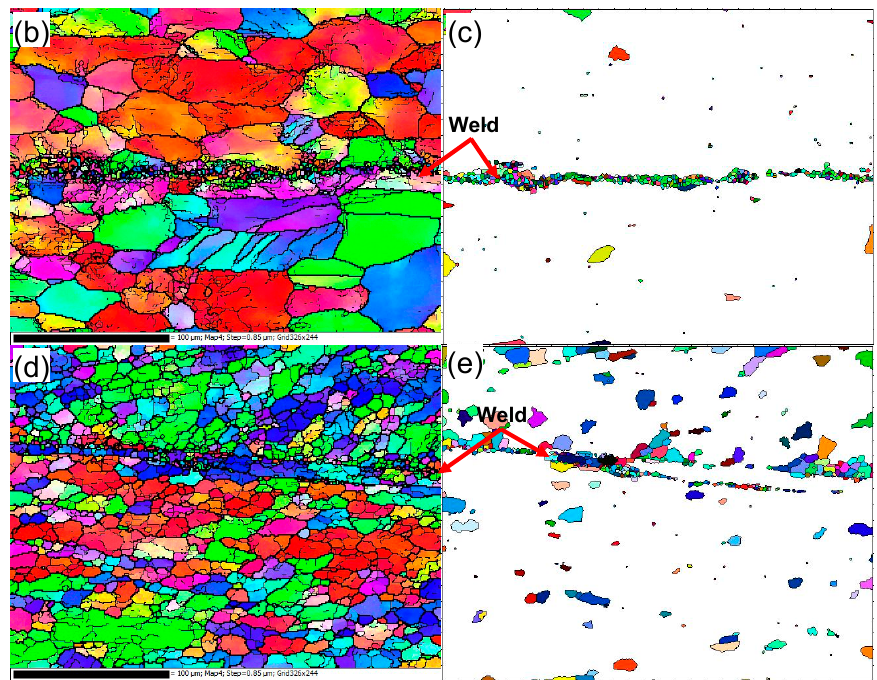
Figure 2. Typical electron backscatter diffraction (EBSD) orientation maps of 6022-T43 Al alloy from ( a ) Base metal (BM); ( b , c ) USWed joint made with a welding energy of 800 J; and ( d , e ) USWed joint made with a welding energy of 1400 J.